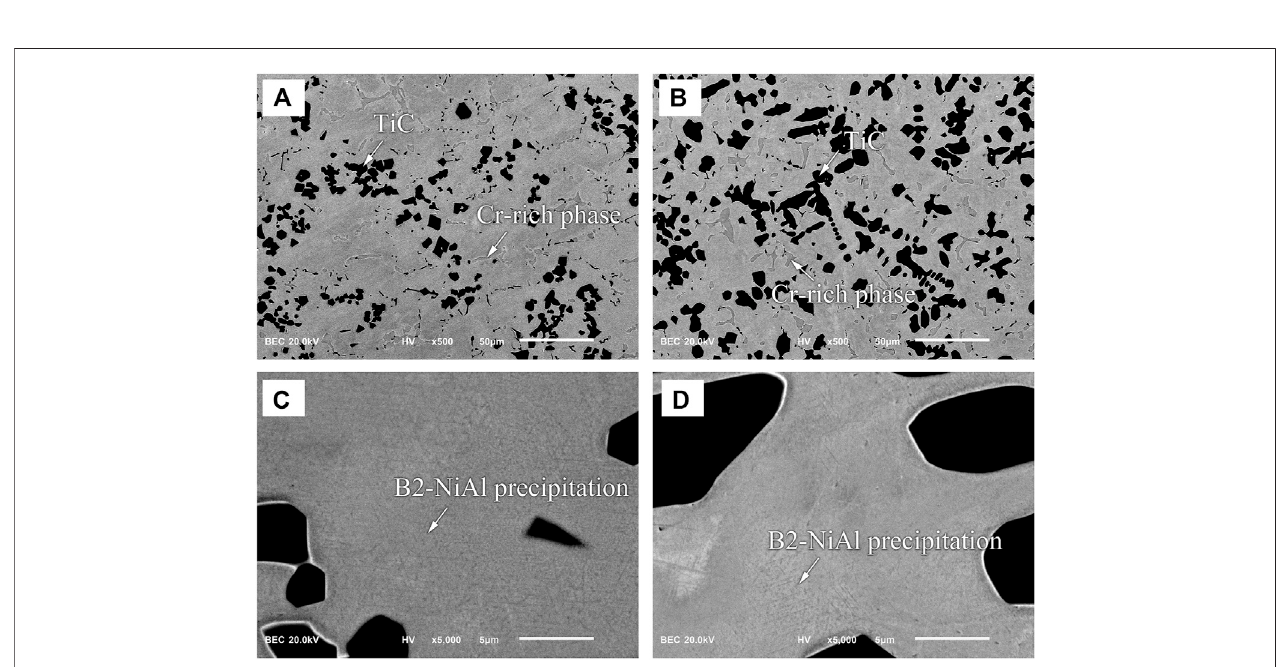
FIGURE 3 | SEM of (A) as-cast TC02, (B) as-cast TC05, (C) as-aged TC02, and (D) as-aged TC05 alloys.